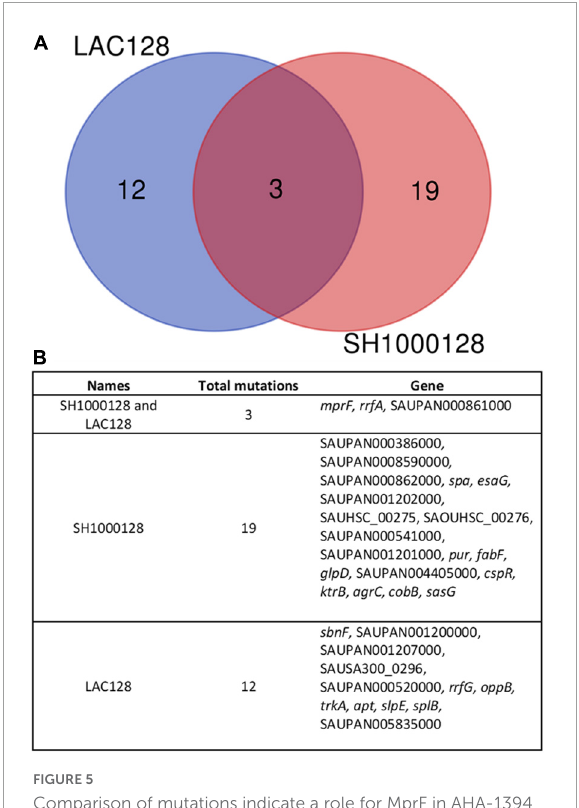
FIGURE5 Comparison of mutations indicate a role for MprF in AHA-1394 resistance. (A) Venn diagram showing mutations unique to LAC-128 (blue), unique to SH1000-128 (red) and mutation shared by both mutants (mauve) when compared to the parental strains LAC-B and SH1000-B. (B) Descriptions of mutations present and shared in LAC-128 and SH1000-128. Pangenome locus tags are shown (“SAUPAN”). Where a pangenome locus tag is missing the relevant